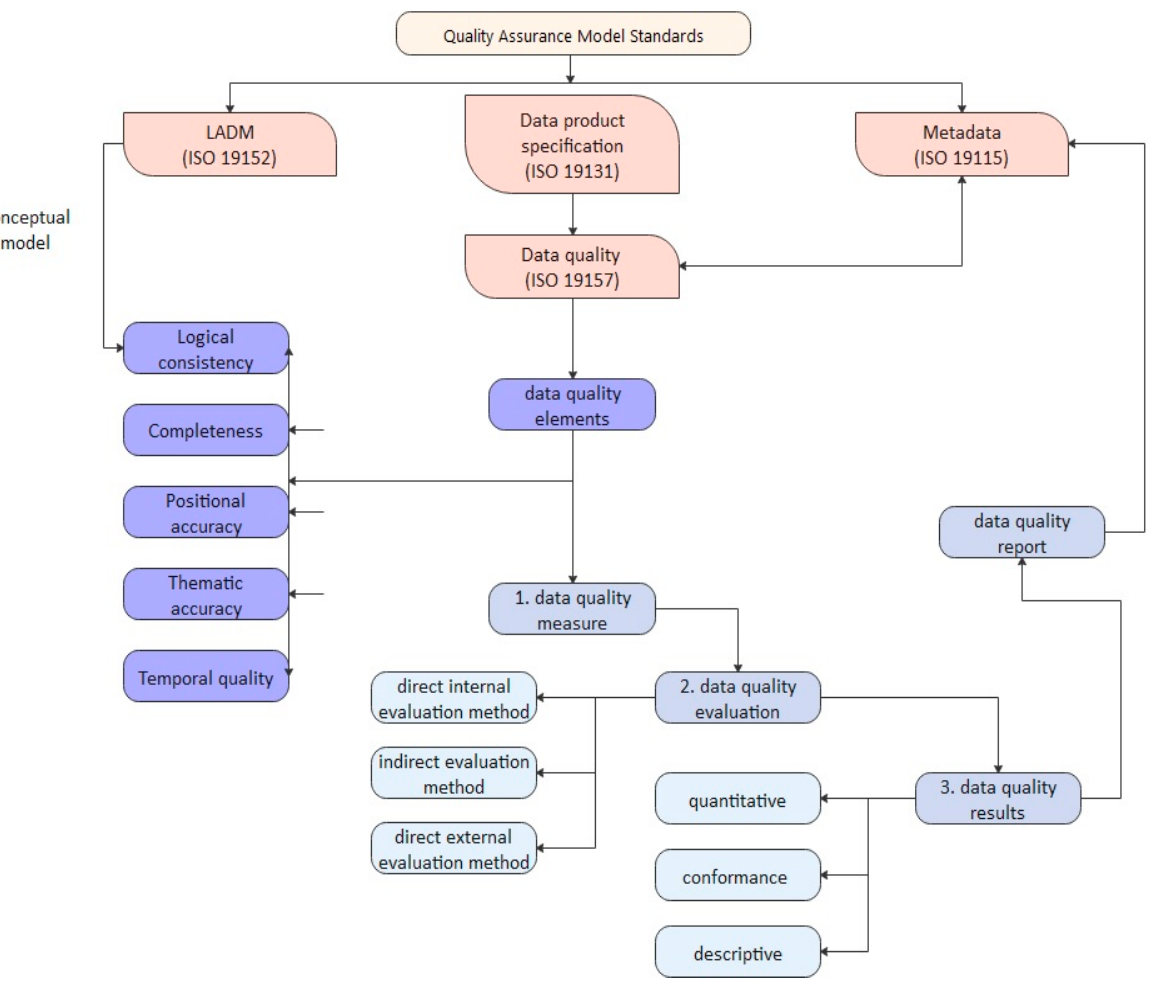
Figure 3. Standards of the FFP quality assurance model.